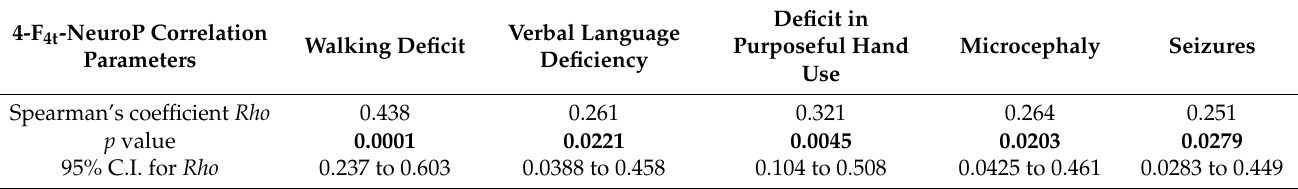
Table 5. Correlation matrix for 4-F 4t -NeuroP as a function of RCSS sub-components.